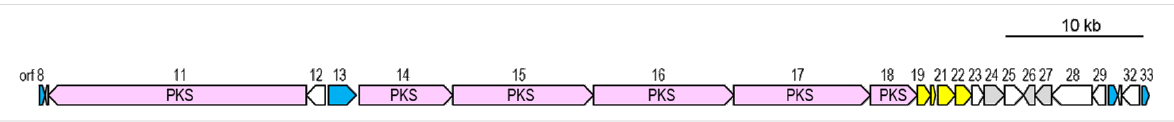
Figure 5: Organization of the biosynthesis gene cluster for 1 . Blue, transcriptional regulator; pink, PKS for polyketide backbone of 1 ; yellow, genes for biosynthesis of hydroxymalonyl-ACP; gray,